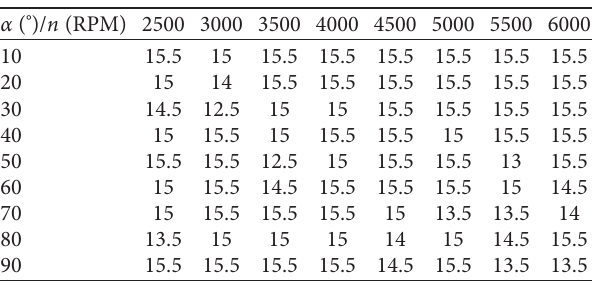
Table 6: Optimize calibration data of fuel injection